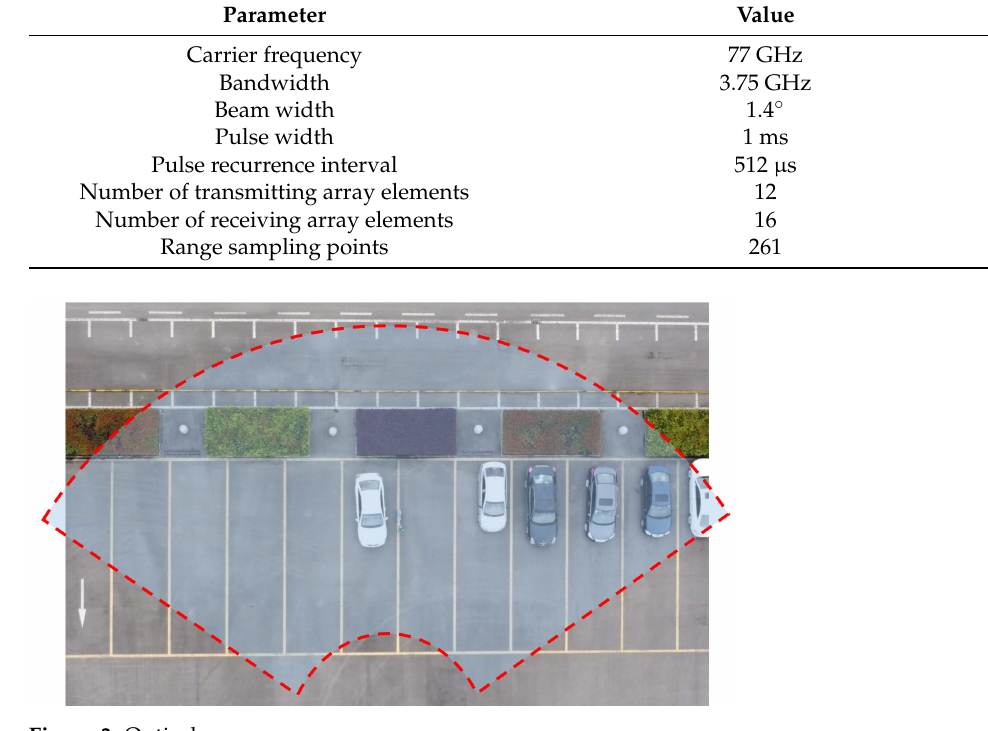
Figure 3. Optical